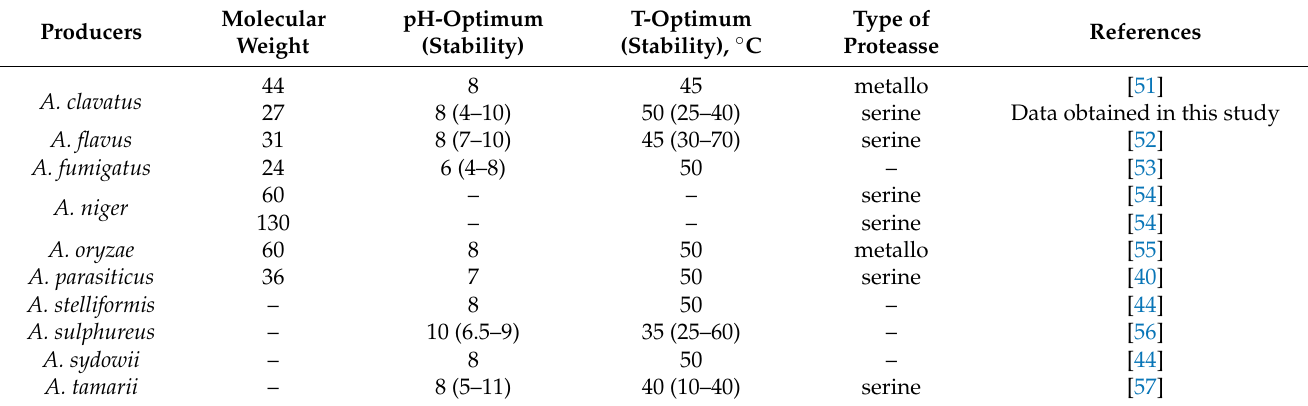
Table 4. Properties of some known Aspergillus